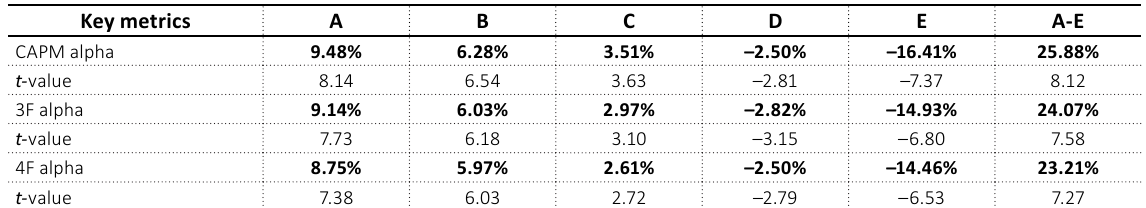
Table 13. CAP M style alpha, three-factor and four-factor alphas of volatility ranked portfolios controlled for